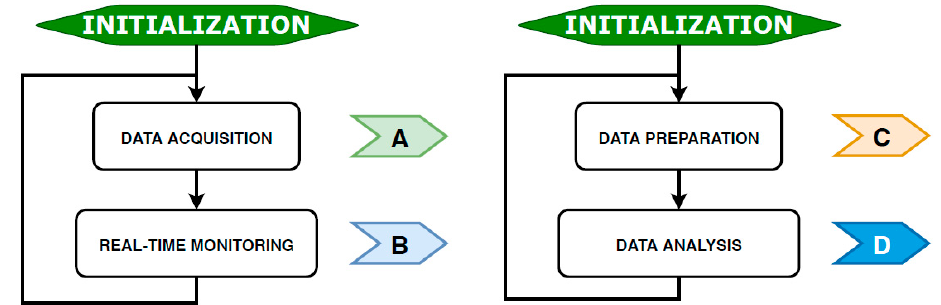
Figure 18. Structure of the proposed system; elements marked with black font are obligatory and elements marked with blue font are optional.